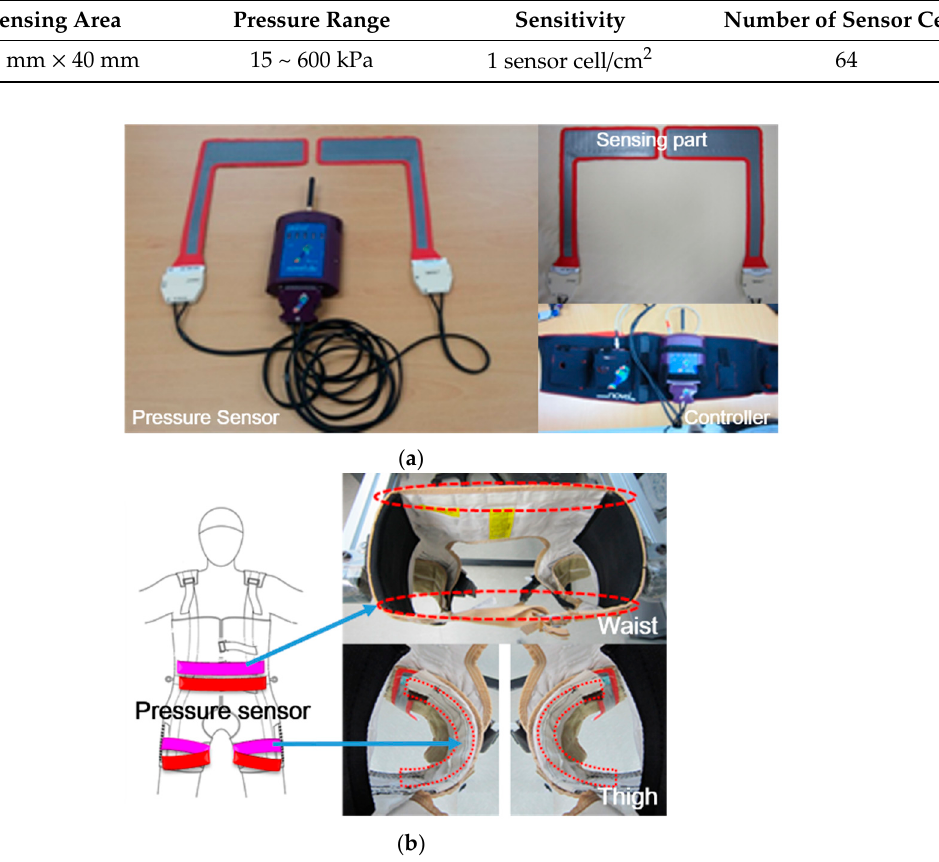
Figure 6. ( a ) Strap-type pressure sensor and controller and ( b ) pressure sensor location in the harness.